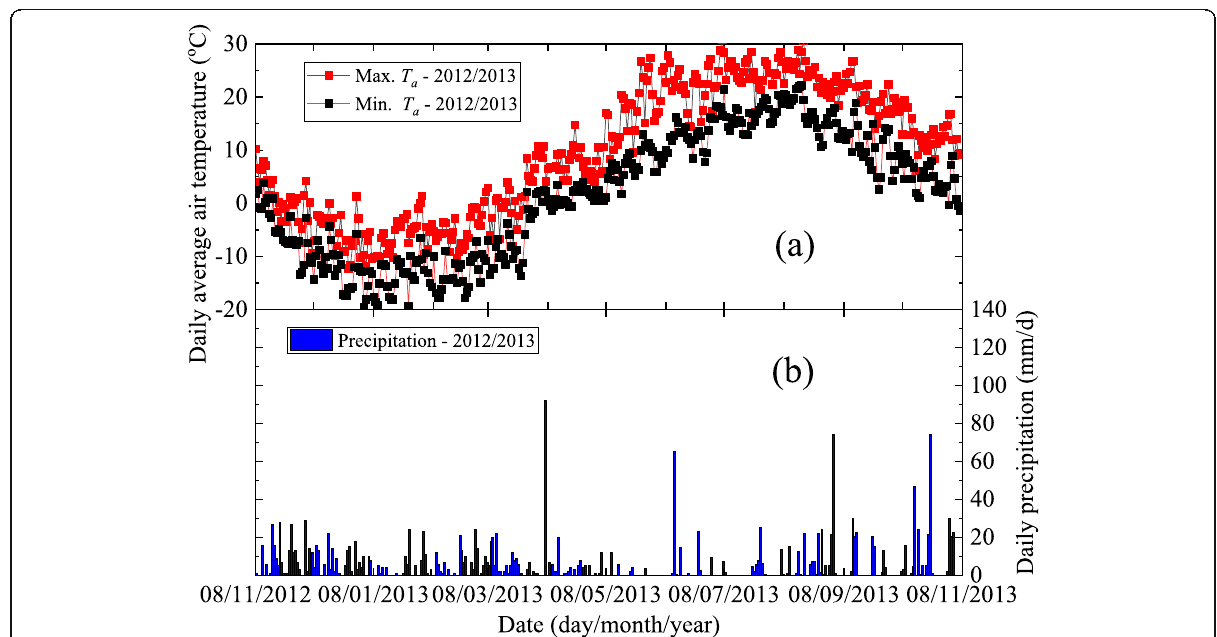
Fig. 6 Original climate data obtained from the AMeDAS at Nakayama